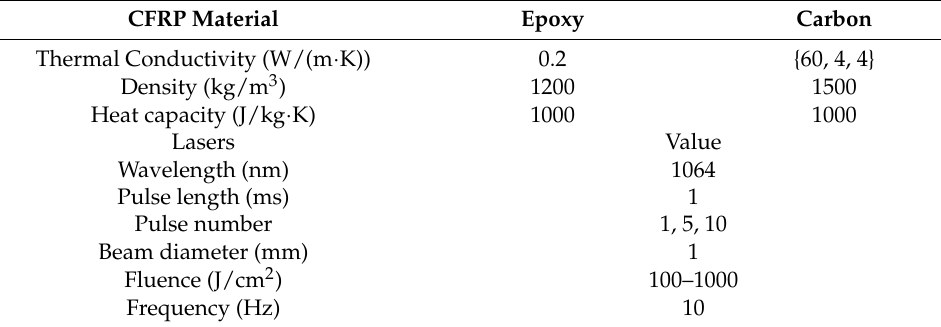
Table 1. Parameters of CFRP material and